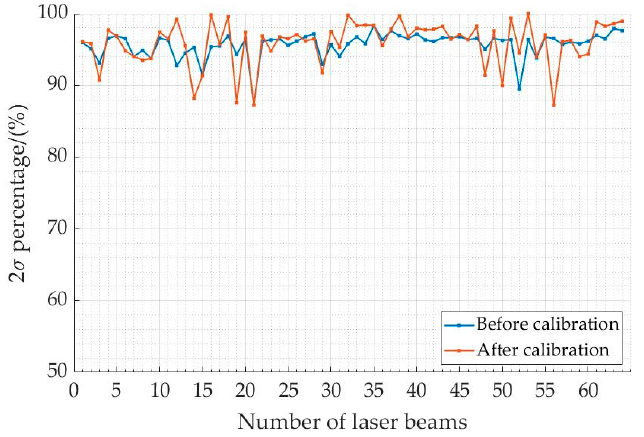
Figure 13. The percentage of points within the 2 σ confidence interval for the distance standard deviation from the point to the calibration plane.